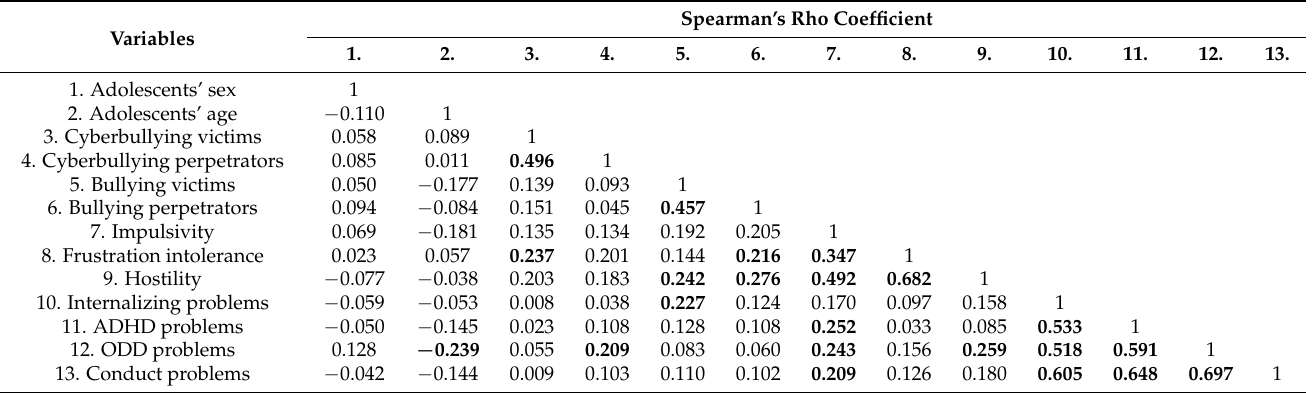
Table 2. Correlation between studied variables: Spearman’s rank-order